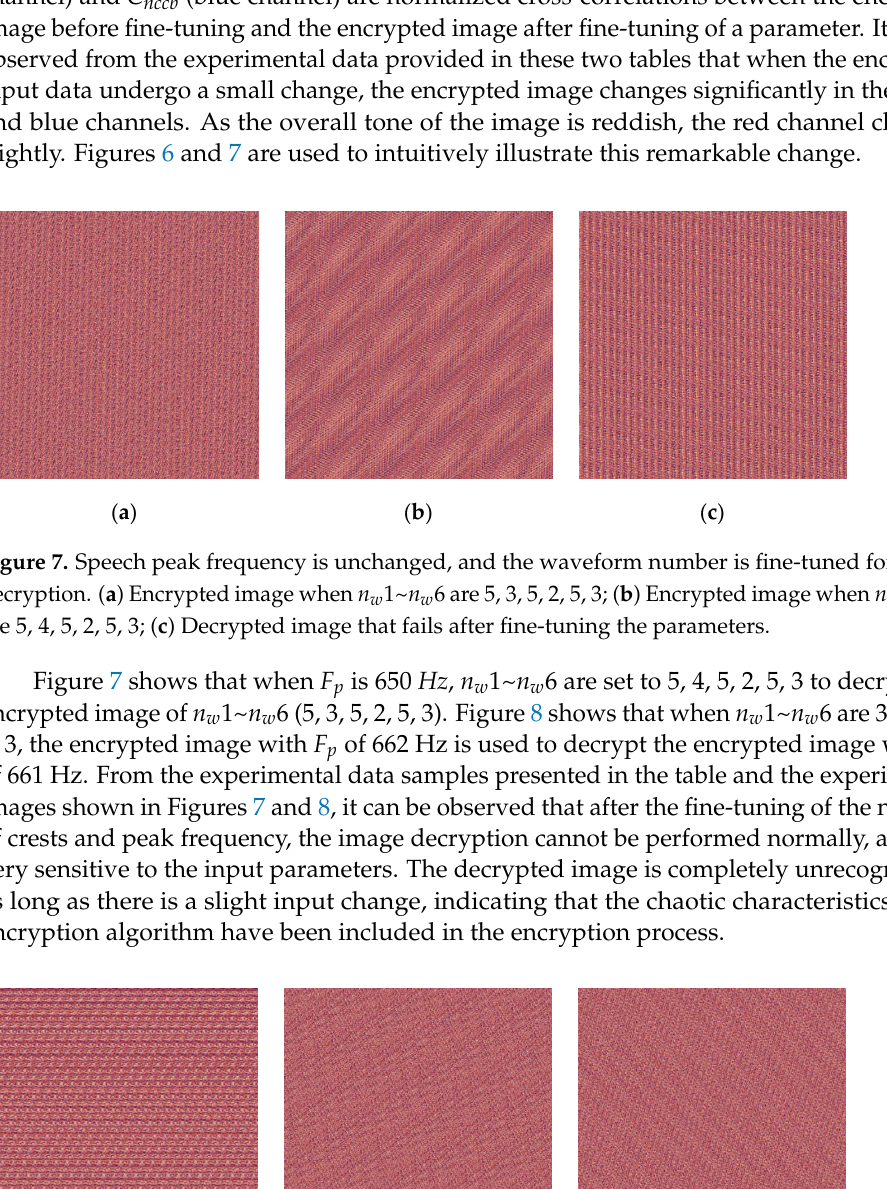
Figure 8. Unchanged n w 1~ n w 6, image decryption with fine-tuned voice peak frequency. ( a ) Encrypted image when F p is equal to 661 Hz; ( b ) Encrypted image when F p is equal to 662 Hz; ( c ) Decrypted image that fails after fine-tuning the parameters.